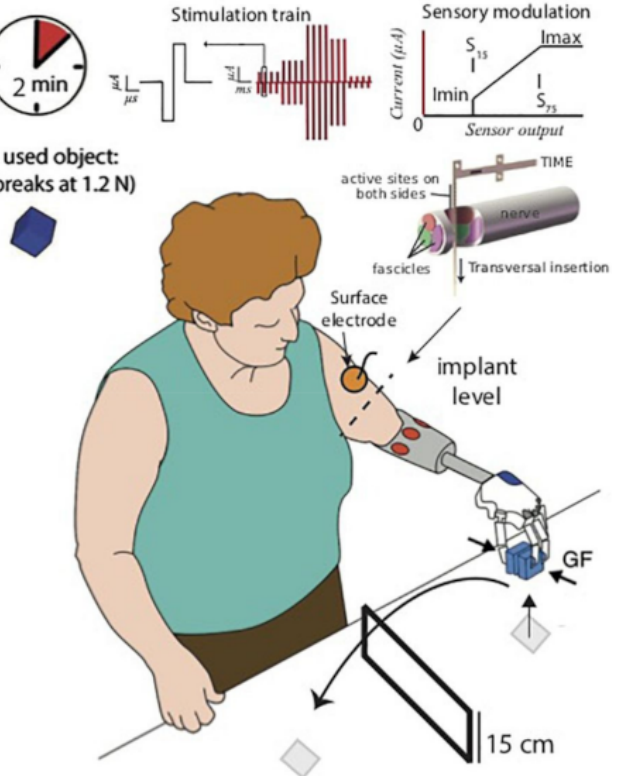
Figure 7. A robotic hand prosthesis powered by surface EMG signals and neural sensory feedback was used by the patient through electrodes implanted in her ulnar nerve. Reprinted with permission from